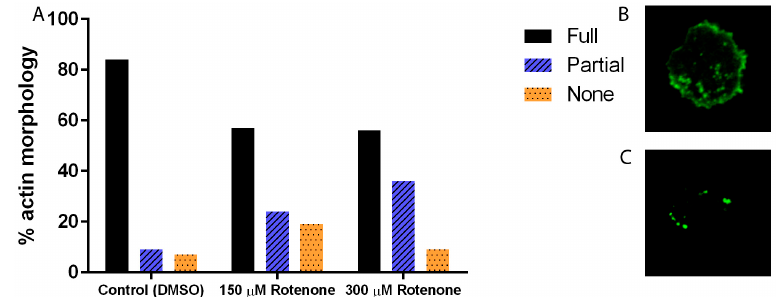
Figure 2. Percent actin morphology of cells treated with DMSO, 150 µ M, or 300 µ M of rotenone. ( A ) Increasing the concentration of rotenone decreased the complexity of the network and length of individual fibers ( p = 0.0013). 84% of DMSO treated cells had full actin networks while 56% of 300 µ M rotenone treated cells retained full actin networks ( n ≥ 40). ( B ) Example of full actin cytoskeleton, and ( C ) partial actin cytoskeleton.